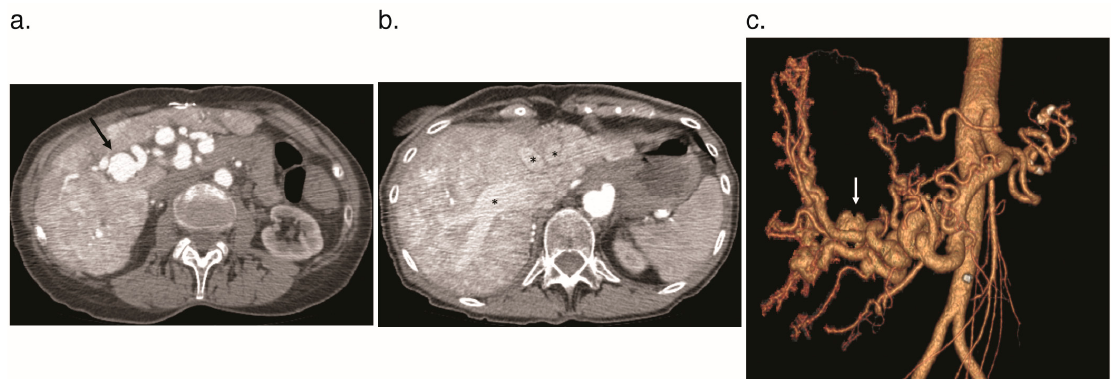
Figure 2. Arteriosystemic shunts on arterial phase CT angiogram of the abdomen in a 73-year-old woman with HHT. ( a ) Marked dilation and tortuosity of the hepatic artery with right hepatic artery aneurysm (arrow). ( b ) Early filling of the hepatic veins (*) on the arterial phase of contrast suggests hepatic arterial to hepatic venous shunting. ( c ) Coronal arterial phase 3D reconstruction demonstrates the marked dilation of the hepatic arteries. The hepatic artery aneurysm is denoted by the arrow.